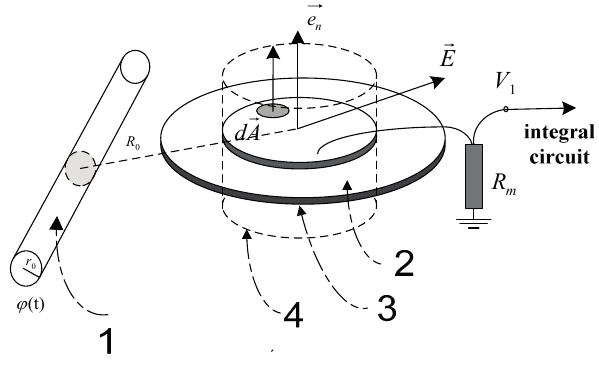
Figure 1. Theory of the traditional D-dot probe.